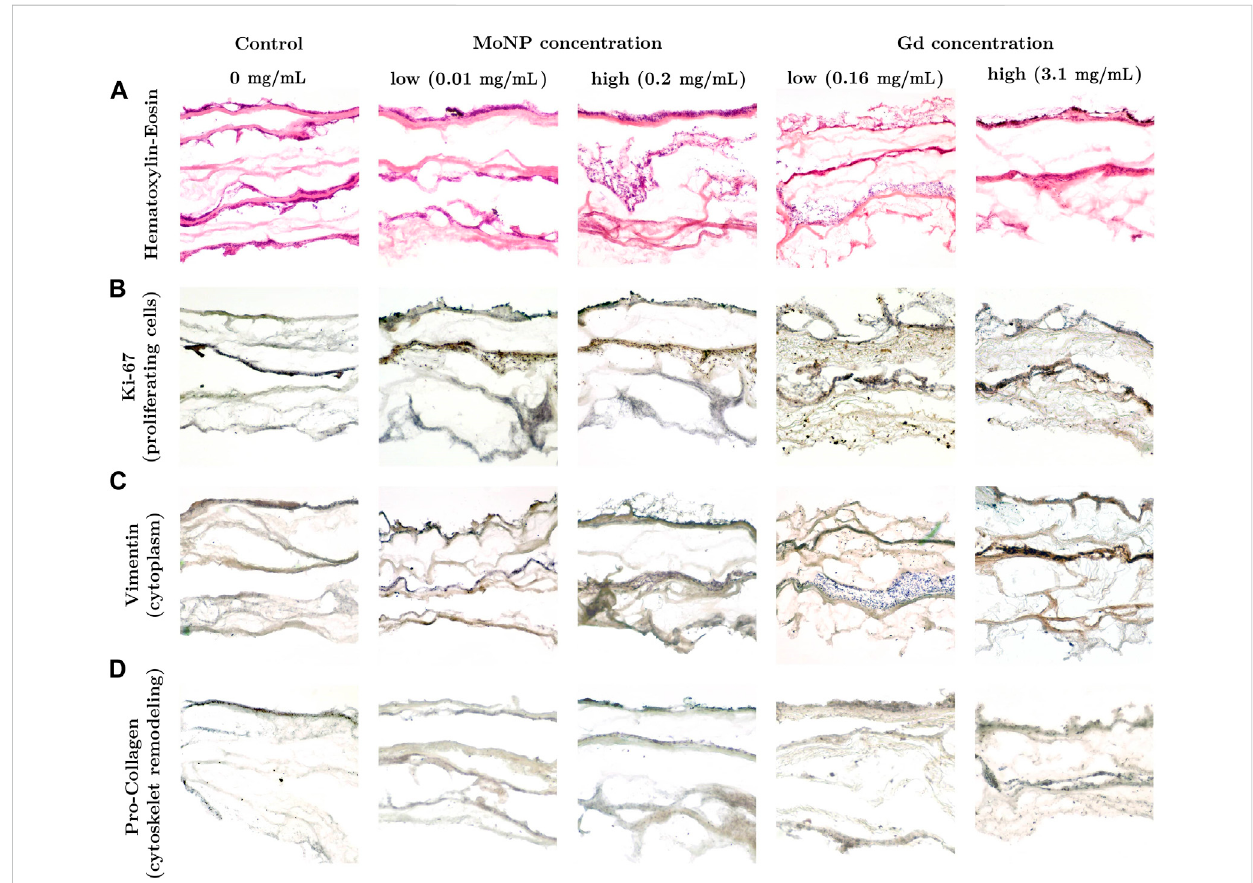
FIGURE 7 (A) HE staining and (B) immunohistochemical stainingagainstKi-67, (C) Vimentinand (D) Pro-Collagen inthe3Dbreastcancer modelcomposedof three layers: primary human fi broblasts, MDA-MB-231 and scaffold after 48 h incubation.